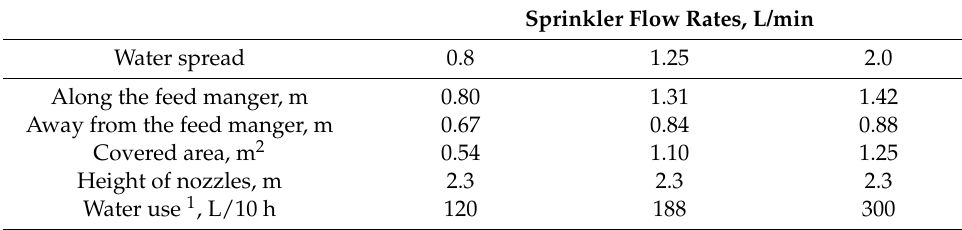
Table 2. Water spread characteristics of different sprinkler flow